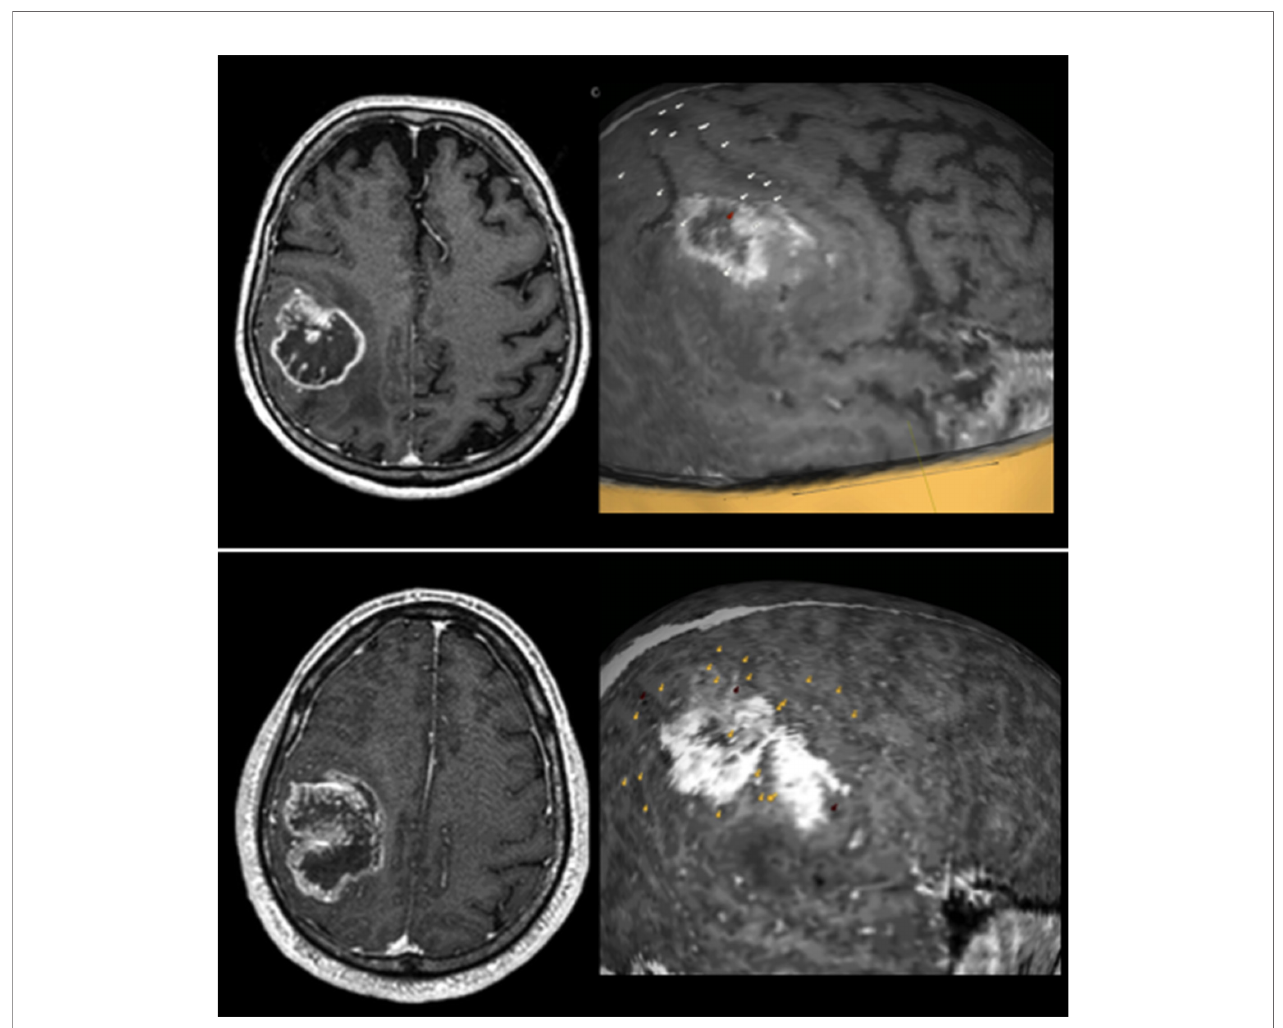
FIGURE 5 | Some examples of the nTMS mapping of VSAs in patients with tumors involving the right parietal lobe. In all three cases some nTMS spots are overlapped to the lesions, suggesting a high risk for postoperative VSAs de fi cits. Spots are color-coded: white = performance errors; red = language-based errors; yellow = part